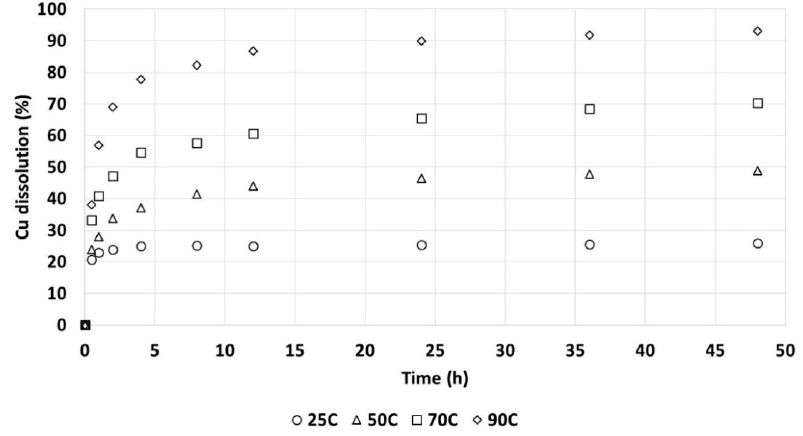
Figure 12. The dissolution of copper from copper sulphide ores with pretreatment (a) in 0.2 M of H 2 SO 4 and 50 g/L of Cl − in deionized water at 25 °C ( ○ 25), 50 °C ( Δ 50), 70 °C ( □ 70), and 90 °C ( ◊ 90).